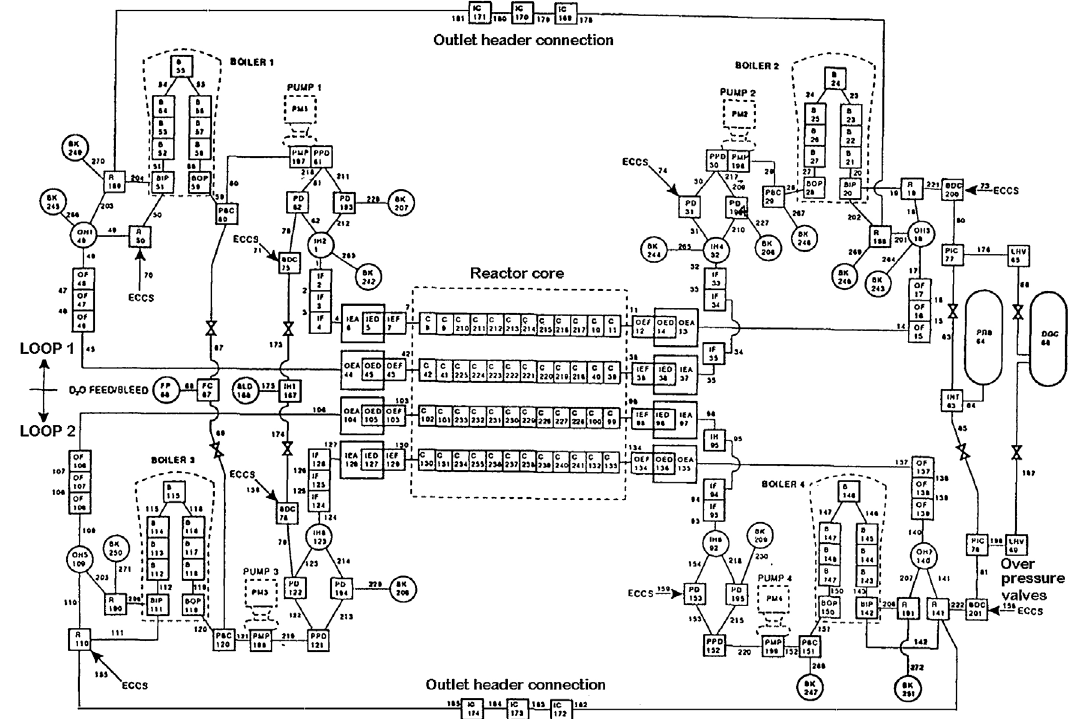
Fig. 1. CANDU coolant main circuit mapping